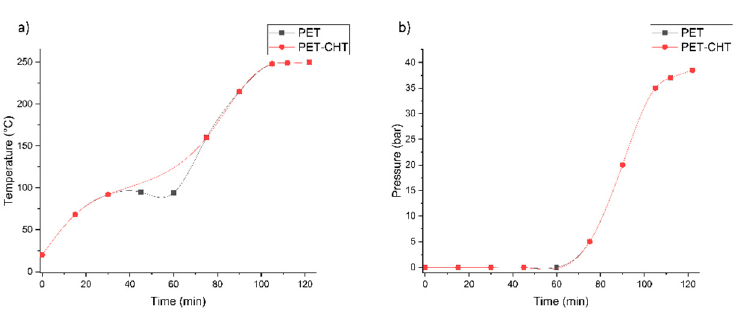
Figure 4. ( a ) Time–temperature dependence alkaline hydrolysis of PET and PET–CHT. ( b ) Time– pressure dependence alkaline hydrolysis of PET and PET–CHT.